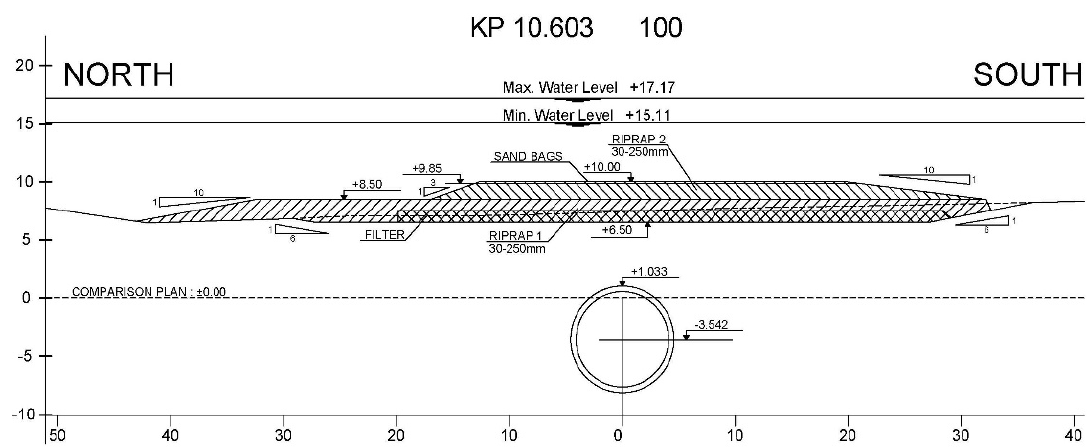
Figure 10. Cross section of backfilling protection.